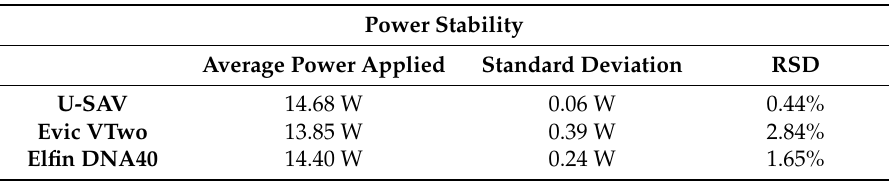
Table 3. Power variation from 36 measurements (6 per U-SAV line) comparing energy delivery from U-SAV with two commercial EC battery